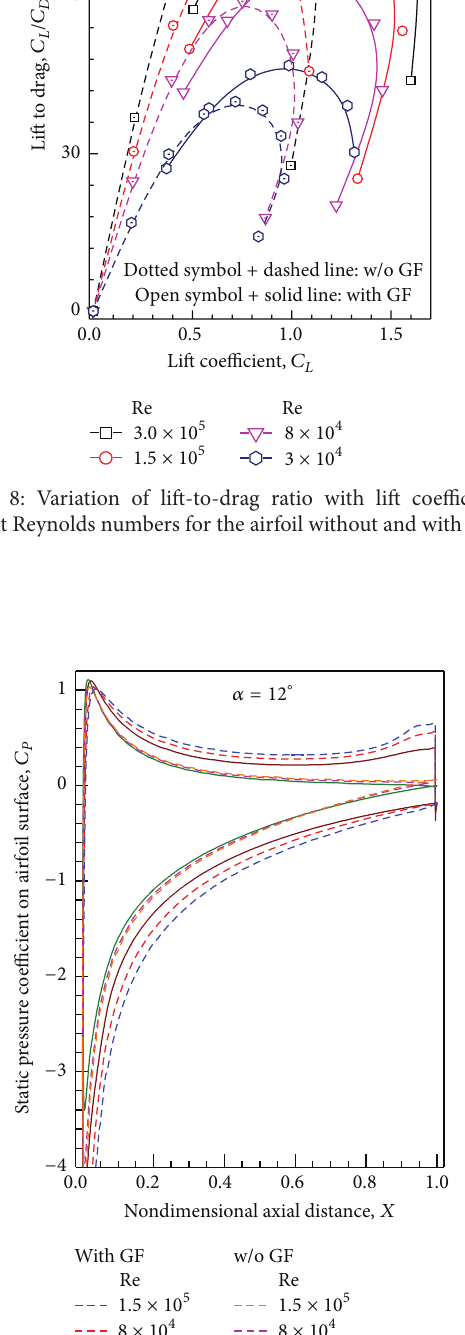
Dotted symbol + dashed line: w/o GF Open symbol + solid line: with GF